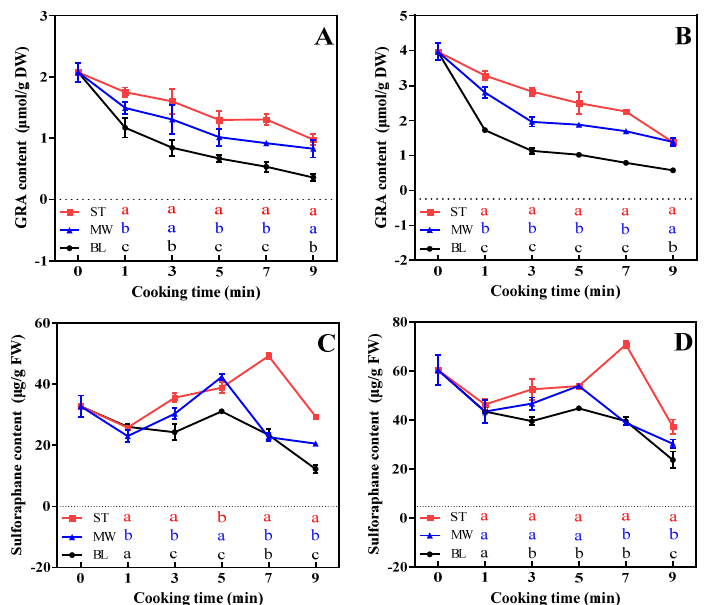
Figure 5. Effects of cooking method on glucoraphanin and sulforaphane contents in broccoli florets. Glucoraphanin content (( A ): Yanxiu, ( B ): Xianglv No.3), sulforaphane content (( C ): Yanxiu, ( D ): Xianglv No.3). Red lines, steaming, blue lines, microwaving; black lines, boiling. Error bars represent SD from three replications of under every treatment under cooking experiment. Different letters indicate statistically significant differences among treatments ( p < 0.05).